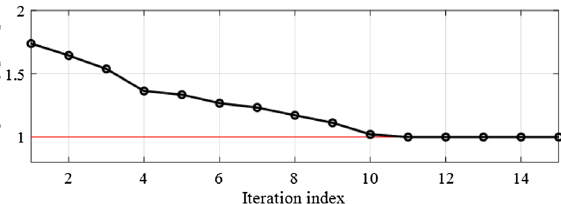
Figure 7. Branch-line coupler: evolution of the target frequency versus iteration index of the optimization algorithm. Original target frequency marked using a horizontal line.